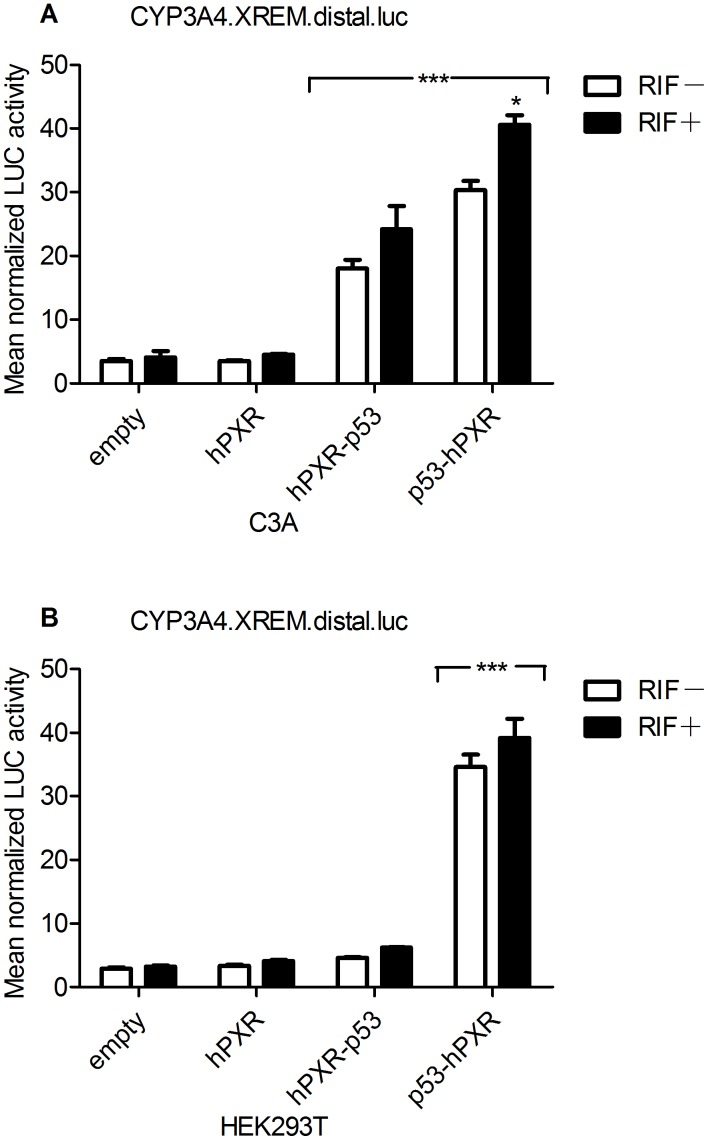
Activation of CYP3A4.XREM.luc luciferase reporter by various hPXR constructs in WT C3A and HEK293T cells.The empty vector contained the pCI-neo plasmid instead of hPXR construct. The ligand (black columns) was 20 µM RIF while vehicle (white columns) was 0.02% (v/v) DMSO. The ratio of reporter luciferase activity to control renilla luciferase activity is indicated. Results are expressed as the mean±S.D. of normalized luciferase activity of three independent measurements. Statistical significance p<0.05: *, RIF-treated vs. respective DMSO control; ***, chimeric hPXR vs. WT hPXR vector.